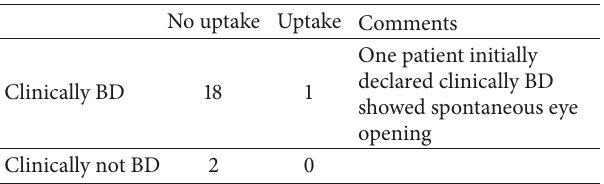
Table 1: Summary of 21 radionuclide scans for brain death determi- nation at our